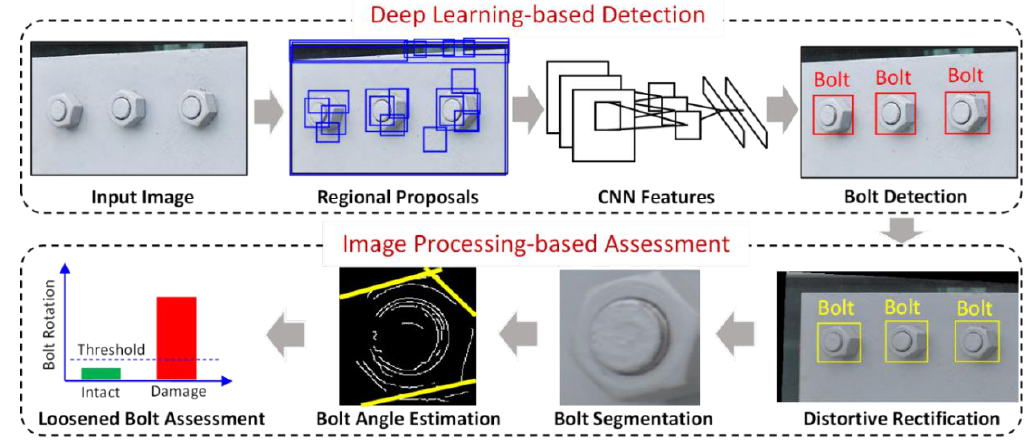
Figure 2. The image-based deep learning model for bolt-loosening detection.